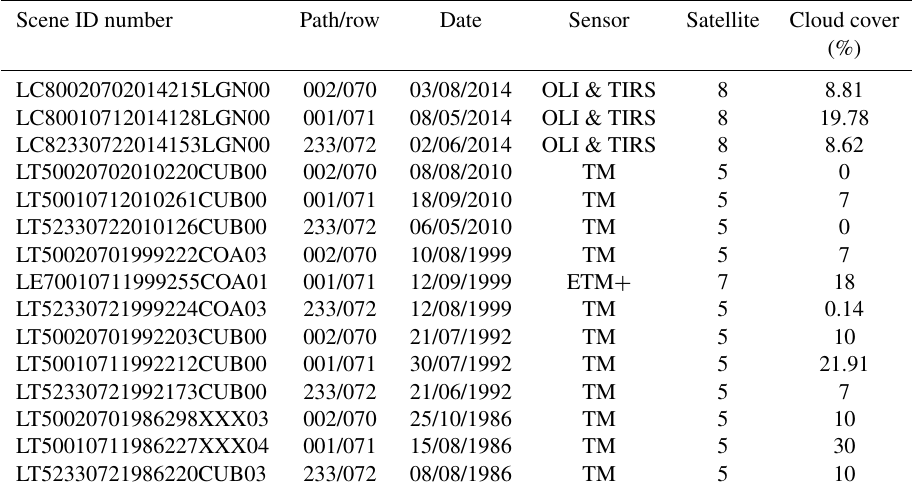
Figure 1. Location of the study area. (a) Topographic map of Bolivia indicating the footprint (grey squares) of Landsat imagery used in this study; (b) extent of the glaciated regions (shown in black as of 2014) of the Cordillera Oriental within the footprint of the satellite imagery. Base map is the Esri World Shaded Relief map (2014). Table 1. Summary of Landsat scenes used in this study. Scene ID number Path/row Date Sensor Satellite Cloud